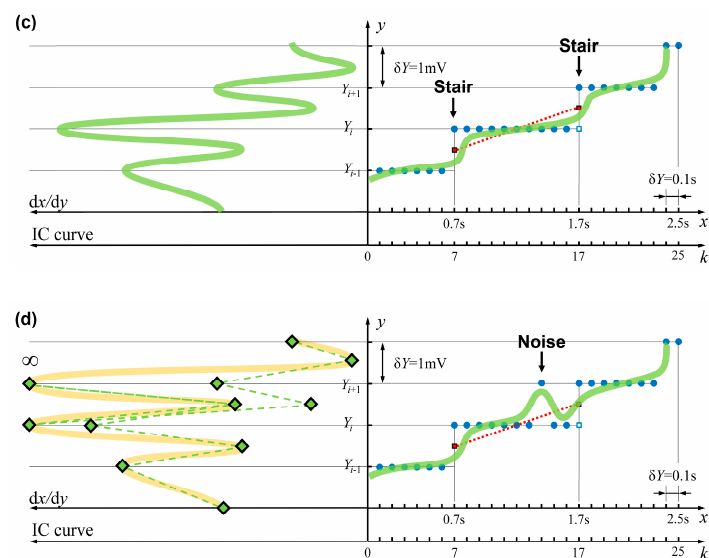
Figure 5. Establishment of criterion for evaluating the quality of curve fitting by SVR. ( a ) The approximate linear differentiation that the SVR method dedicates to capture. ( b ) A case of good fit for the SVR method. ( c ) A case of bad fit, caused by overfitting the shape of stairs for the discretized data. ( d ) A case of bad fit, caused by overfitting the shape of noise.